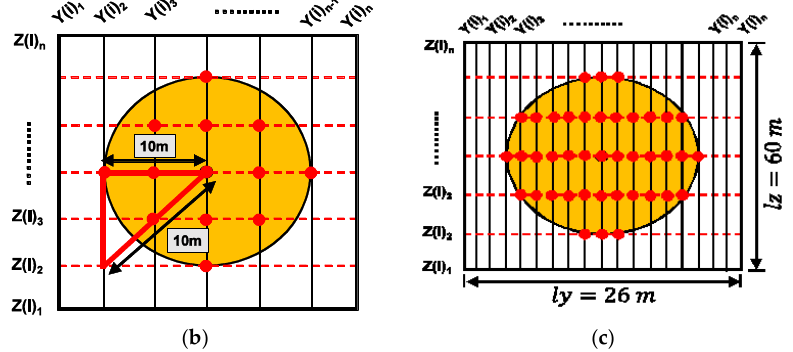
Figure 3. Graphical information exhibiting the influence of the vertical resolutions (24 layers) on the model. Sigma layers and their corresponding depth are presented in drawing ( a ), where the respective planes that cross the disc’s surface area are clearly shown. Detailed illustration on the comparison of the structured grid density nodes at the turbine swept area ( y – z axis) are respectively given in the ( b ) structured grid with minimal resolution and in the ( c ) structured grid with higher density. 𝑌(𝐼) 𝑖 refers to the nodes in the y orientation of the structured grid, while 𝑍(𝐼) 𝑖 corresponds to the i th vertical planes imposed on the model. Note that these figures are not drawn to scale.